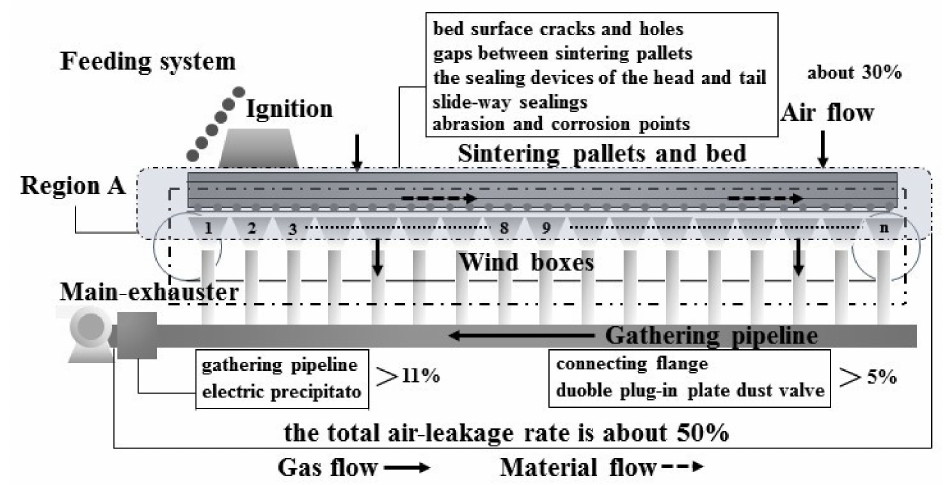
Figure 1. Air leakage distribution in the sintering machine.